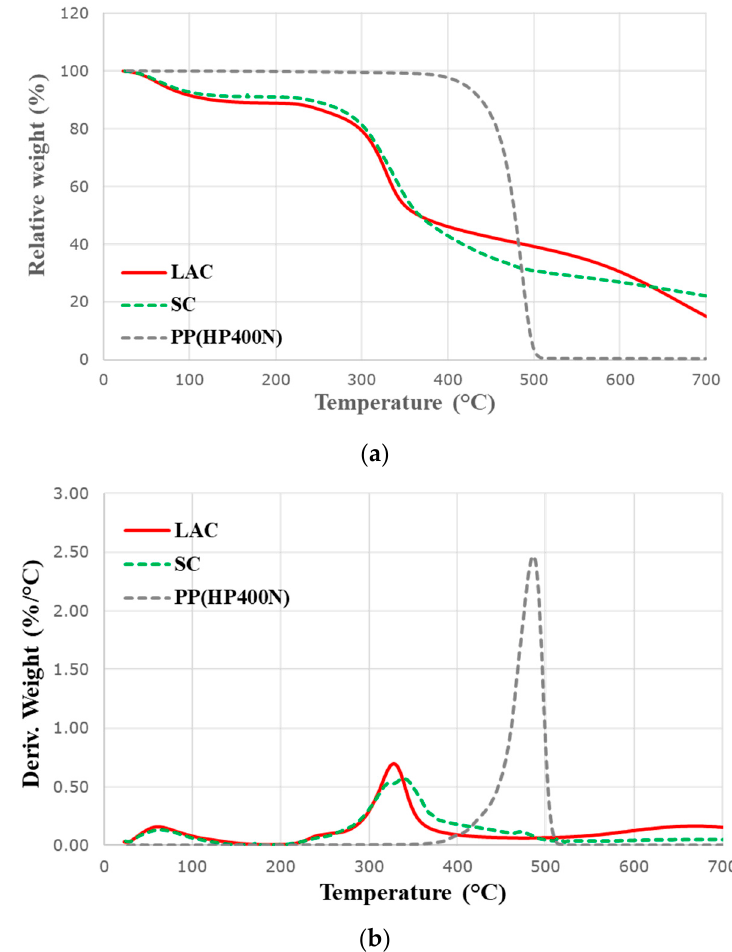
Figure 3. ( a ) Thermogravimetric and ( b ) derivative thermogravimetric curves of neat PP and casein samples in nitrogen. Table 3. Thermogravimetric analysis (TGA) data of neat PP, casein (LAC/SC), and all PP composite samples.